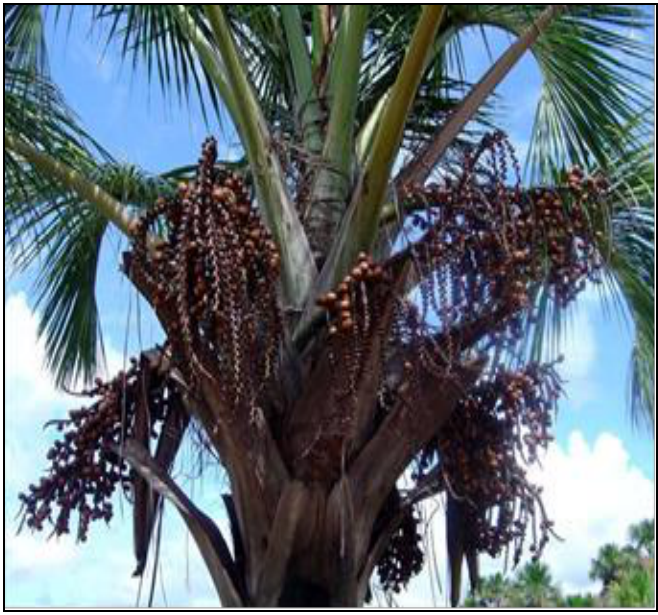
Figura 1: Palmeira de buriti ou Buritizeiro. Fonte: Adaptado do site G1, (2017).